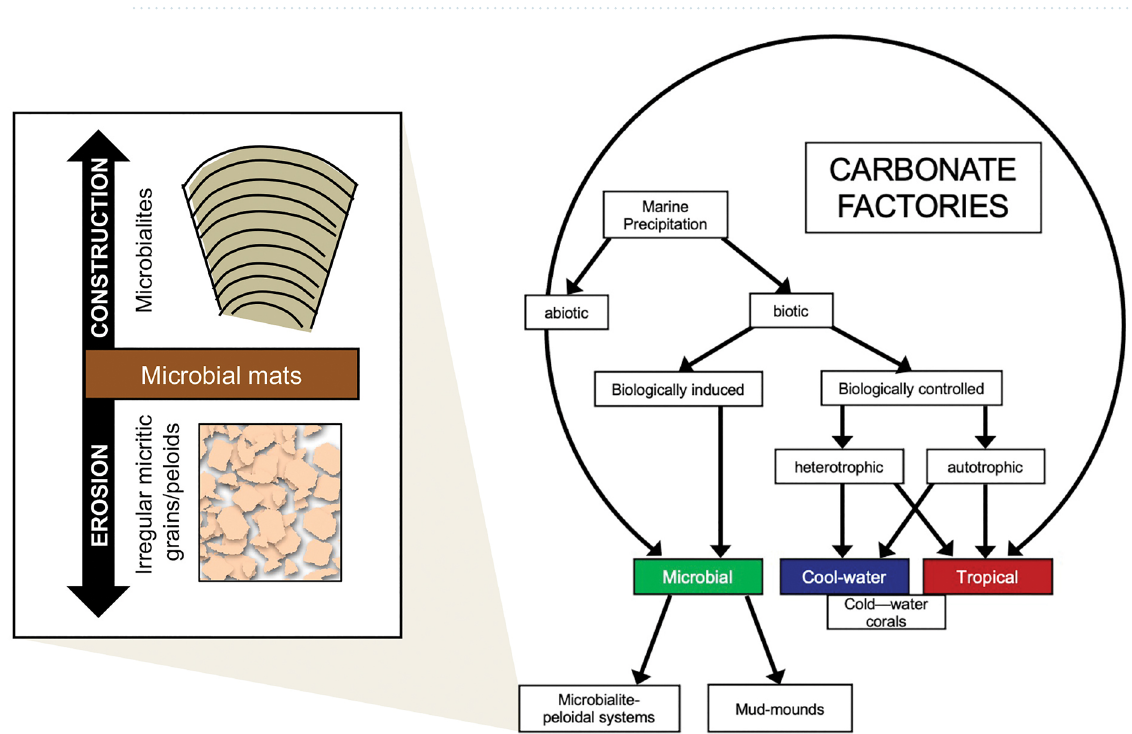
Figure 8. Modification of the Schlager 44 and Reijmer 48 carbonate factory diagram with the inclusion of a microbial pathway informed by the microbialite-peloidal system observed in Hamelin Pool with construction by lithifying microbial mats forming microbialite buildups and erosion of unlithified microbial mats forming sand-sized micritic